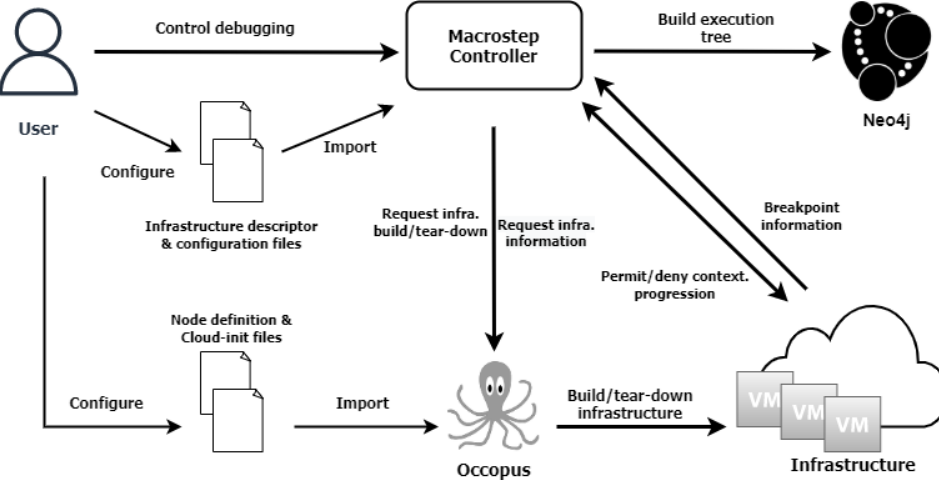
Figure 4. High-level architecture of the experimental prototype of integrated debugger